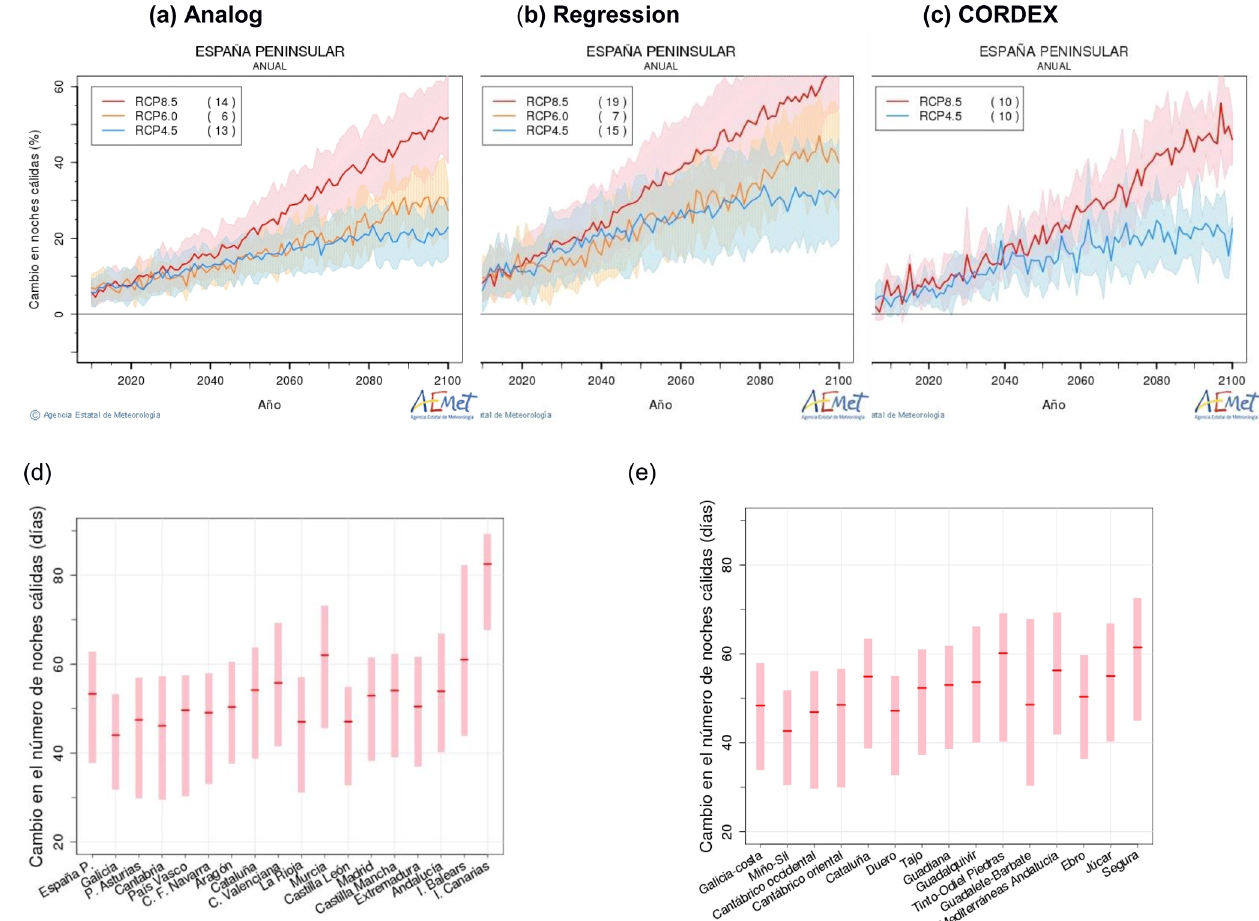
Figure 3. Temporal evolution of the annual change of warm nights for mainland Spain (RCP4.5, RCP6.0, RCP8.5) for: (a) Analog, (b) Regression and (b) EURO-CORDEX methods (a, b, c) . In parentheses, numbers of models considered in each RCP. In (d, e) , mean variation of this index for Autonomous Communities (AC) and Hydrographic Basins (HB). Central line refers to the median of projections while bar is the range between the 17th and the 83th